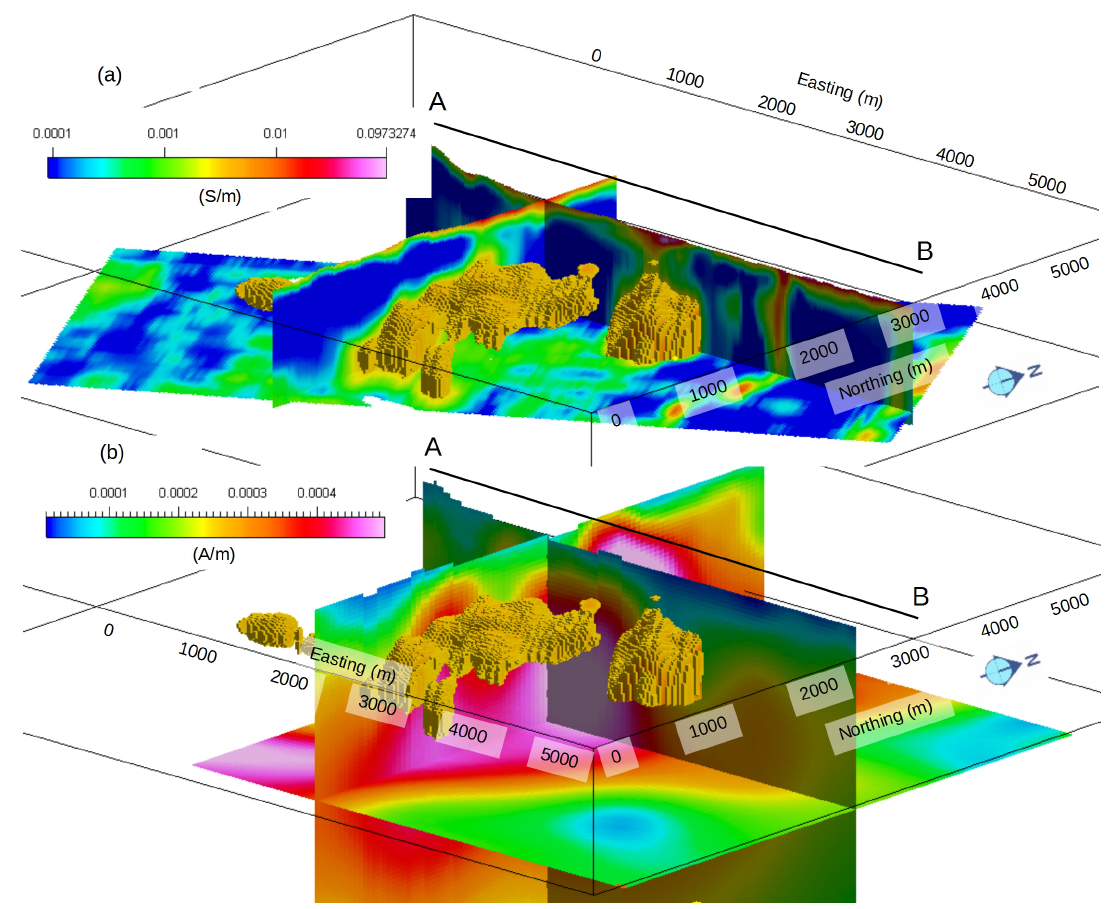
Figure 12. A perspective view of anomalous structure discovered by Glass Earth survey. Panel ( a ) shows a conductivity with cut-off of 5 mS/m and a cross section of conductivity. Panel ( b ) shows the same conductive body from the same perspective, but the cross sections are magnetic vector